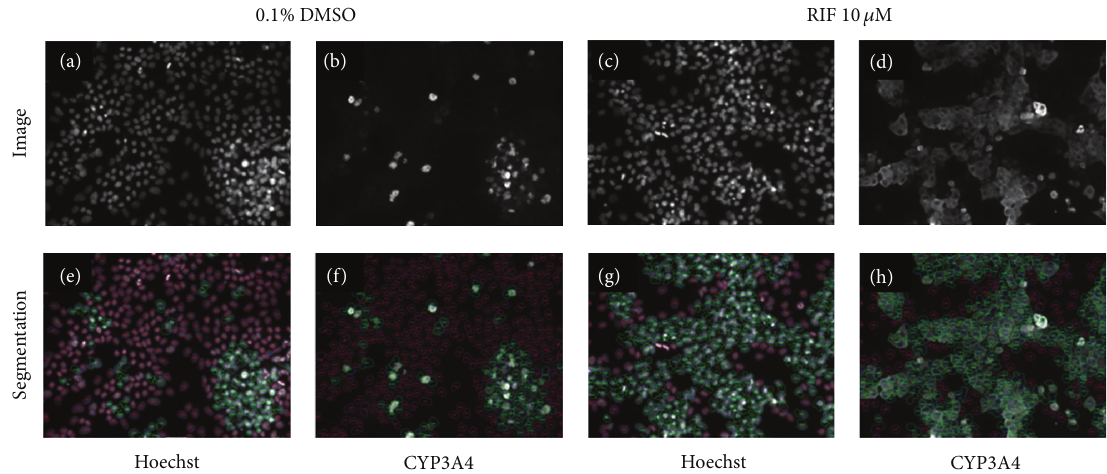
Figure 6: Segmentation of HepaRG cells for CYP3A4 expression using IN Cell Workstation software. This figure illustrates image analysis software tracing specified features of interest in representative images of HepaRG cells seeded at 50,000 cells per well. Upper panels (a–d) show staining images while lower panels (e–h) show image segmentation via HCA image analysis algorithms. Nuclear segmentation is shown by blue outlines in (e–h); cells expressing CYP3A4 are shown by green outlines; cells not expressing CYP3A4 are shown by red outlines. Hoechst nuclear stain is used to identify and count all cells in the images (a + e; c + g). Effects of 10 𝜇 M rifampicin upon CYP3A4 expression versus vehicle control can be seen by comparing (d) with (b; h) and (f) shows the segmentation of CYP3A4 staining which enables subsequent quantitation.